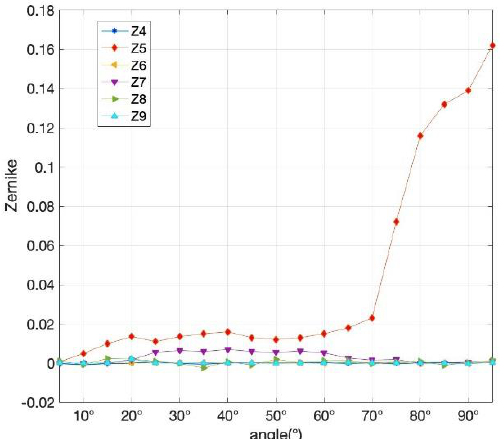
Figure 13. Post-compensation Z4–Z9 change curves in the gravity field.